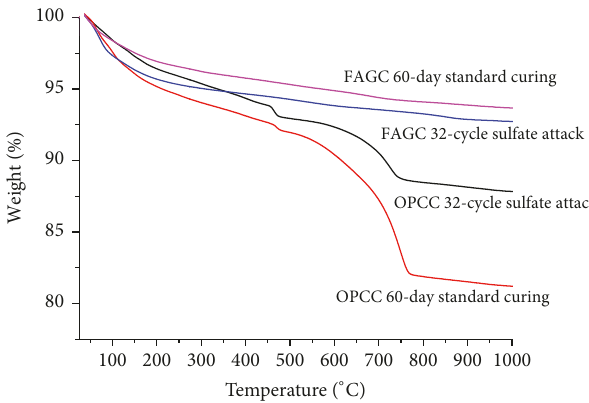
Figure 11: TGA results of OPCC and FAGC in the 60-day standard curing condition and 32-cycle MgSO4 attack environment.